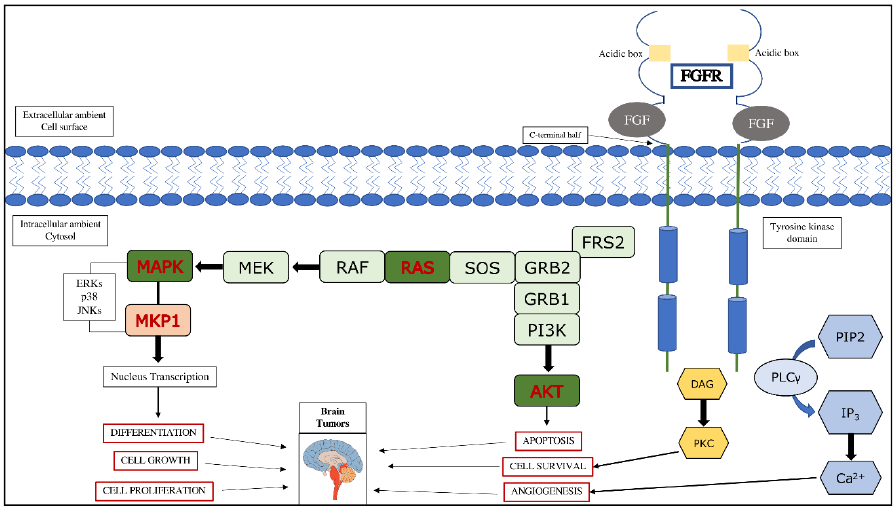
Figure 2. FGF/FGFR signaling pathway and its involvement in brain tumors. FRS2, fibroblast